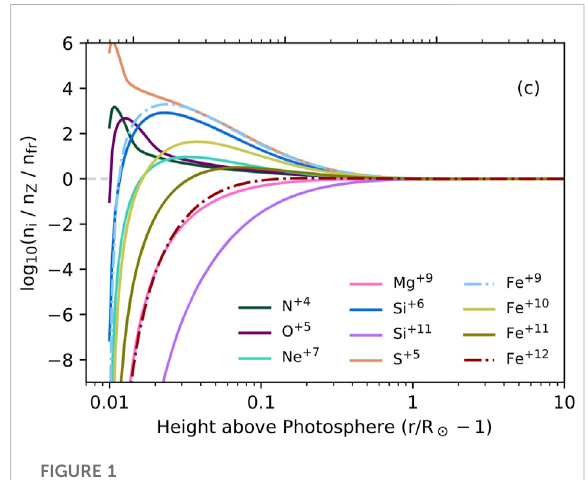
Simulation of the relative abundances to freeze-in value of several ions evolving within a coronal hole, adapted from Gilly and Cranmer, 2020.